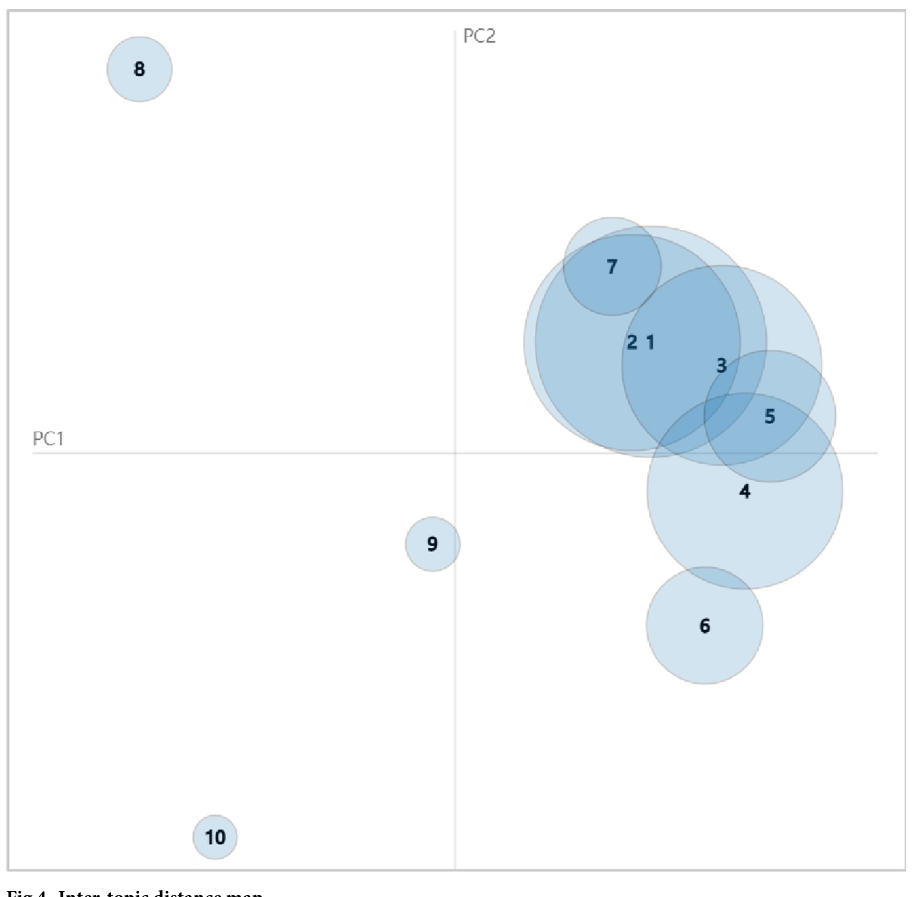
Fig 4. Inter-topic distance map.